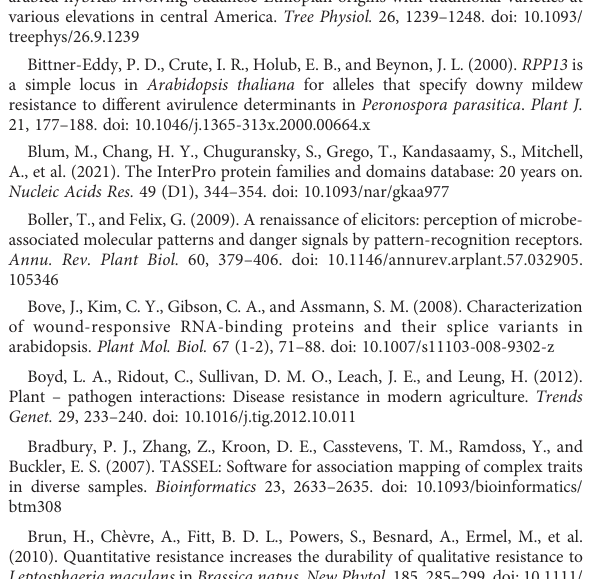
SUPPLEMENTARY FIGURE 1 Histogramofthediseasedistribution,valuesofresponsetoBacterialHaloBlight obtained in fi eld evaluation (Mohan et al., 1978; Ito et al., 2008). The X-axis represents the classes of distribution for the 120 C. arabica wild accessions (blue), 11 C. arabica cultivars (red) and BA-10 genotype evaluated. The Y-axis shows the count of C. arabica genotypes in each category. SUPPLEMENTARY FIGURE 2 Distribution of 11,290 SNPs, identi fi ed in 120 C. arabica wild accessions, 11 C. arabica cultivars and BA-10 genotype, in the C. arabica genome. Each chromosome has its size information in base pairs. The bars correspond to the number of SNPs on each chromosome. SUPPLEMENTARY FIGURE 3 Linkagedisequilibrium(LD)decayfor16,146SNPsobtainedafterquality fi lters and the removal of SNPs from Chr zero. Each point represents a physical distance (bp) between SNPs pairs and their squared correlation coef fi cient (r2). Theredlinerepresentsthelinefornon-linearregressionagainstphysical distance. The green line represents the LD decay value for r2 = 0.2. SUPPLEMENTARY FIGURE 4 Dissimilarity matrix representing the genetic distance between the 120 C. arabica wild accessions, 11 C. arabica cultivars and BA-10 genotype. The color intensity is proportional to the value of genetic distance between the accessions. The matrix was constructed based on the 11,290 SNPs identi fi ed in this population. SUPPLEMENTARY FIGURE 5 Structure analysis of 120 C. arabica wild accessions, 11 C. arabica cultivars and BA-10 genotype. Evolution of D K values (y-axis) according to the number of genetic groups (x-axis).